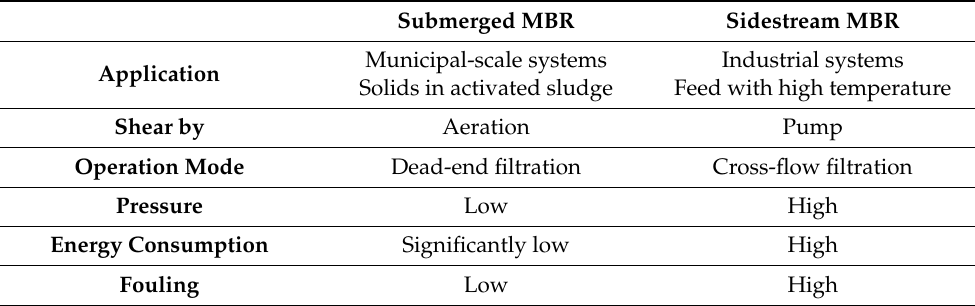
Table 4. Comparison between the two MBR configurations. Adapted from